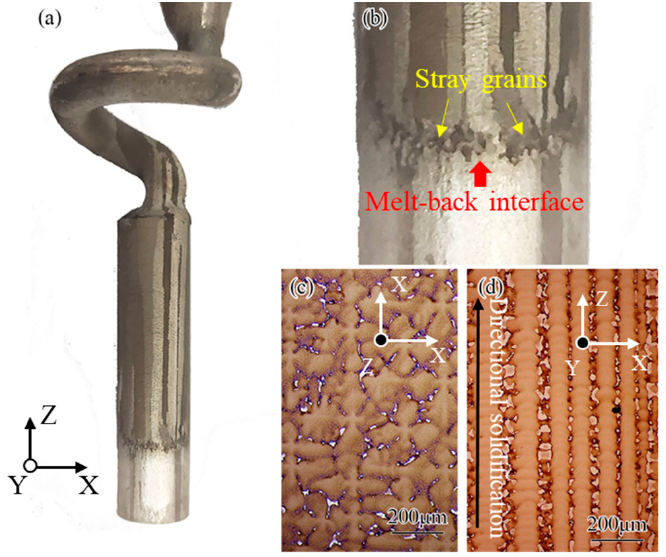
Figure 3. The macrostructure of the adjusted grain selection process assisted by directional colum- nar grains: ( a ) a magnification view near melt-back region; ( b ) cross-sectional; ( c ) longitudinal ( d ) microstructure of casting.